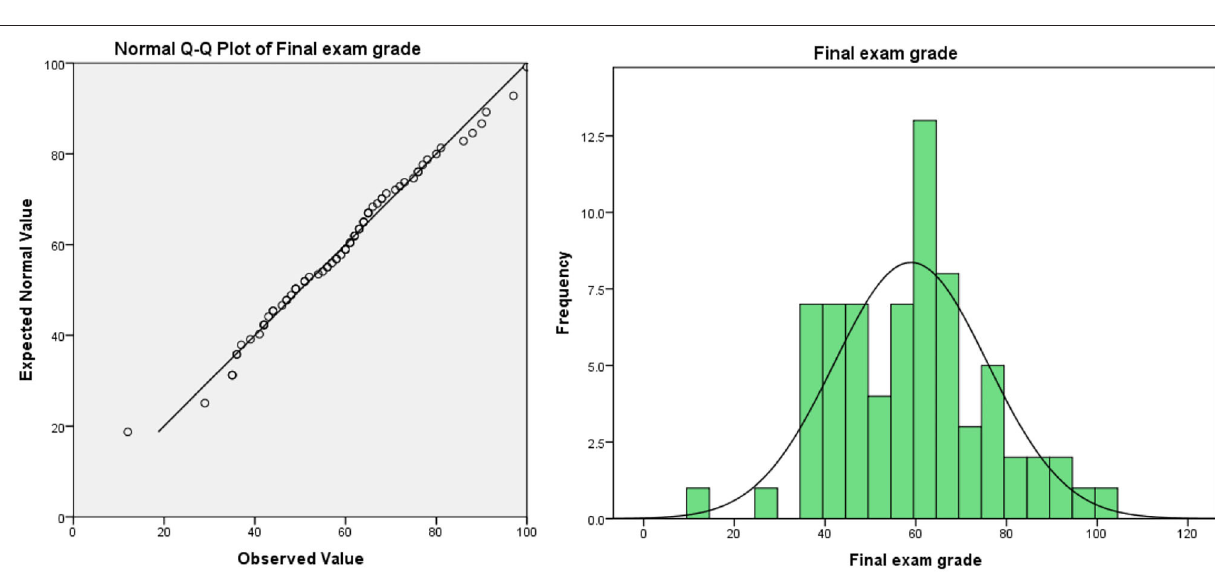
FIGURE 2 | Final exam grade of teacher-oriented graduates majoring in